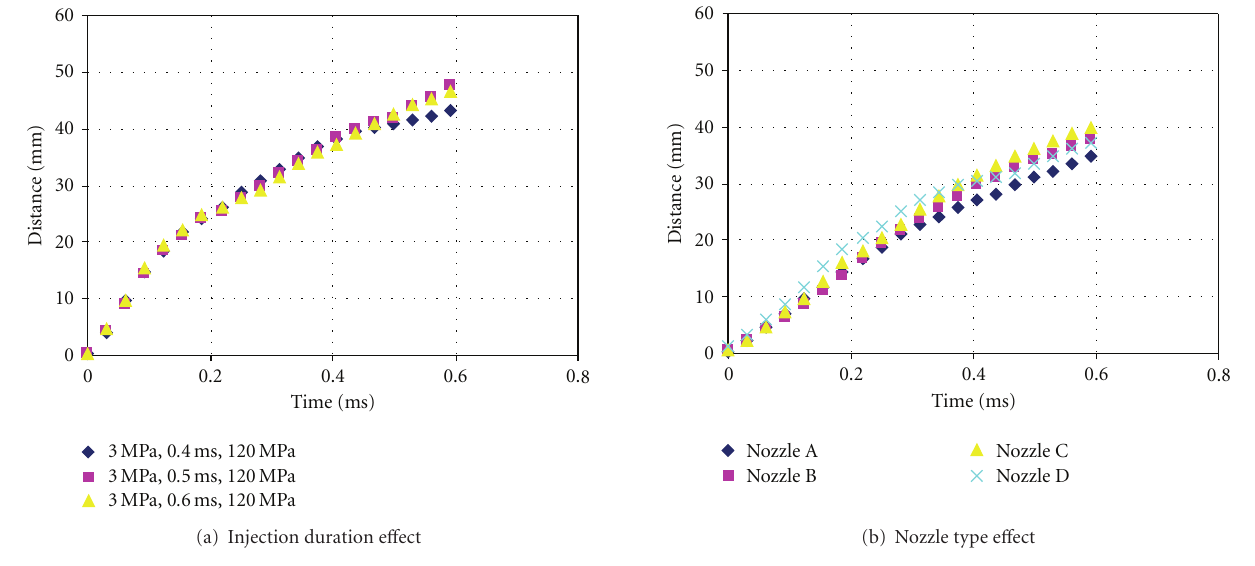
Figure 10: Spray tip penetrations at 300 K ambient temperature (a) Injection duration e ff ect, experimental results with Nozzle D, 3 Mpa ambient pressure, 120 MPa injection pressure; (b) nozzle type e ff ect; 3Mpa ambient pressure, 1.5 ms injection duration, 120 MPa injection pressure.